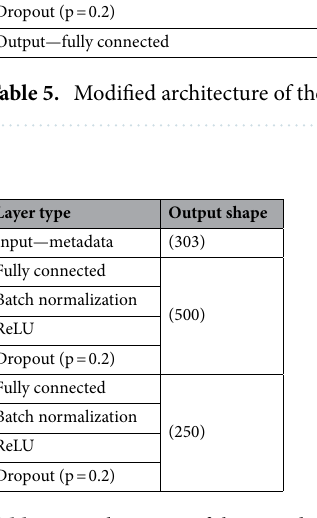
Table 6. Architecture of the metadata